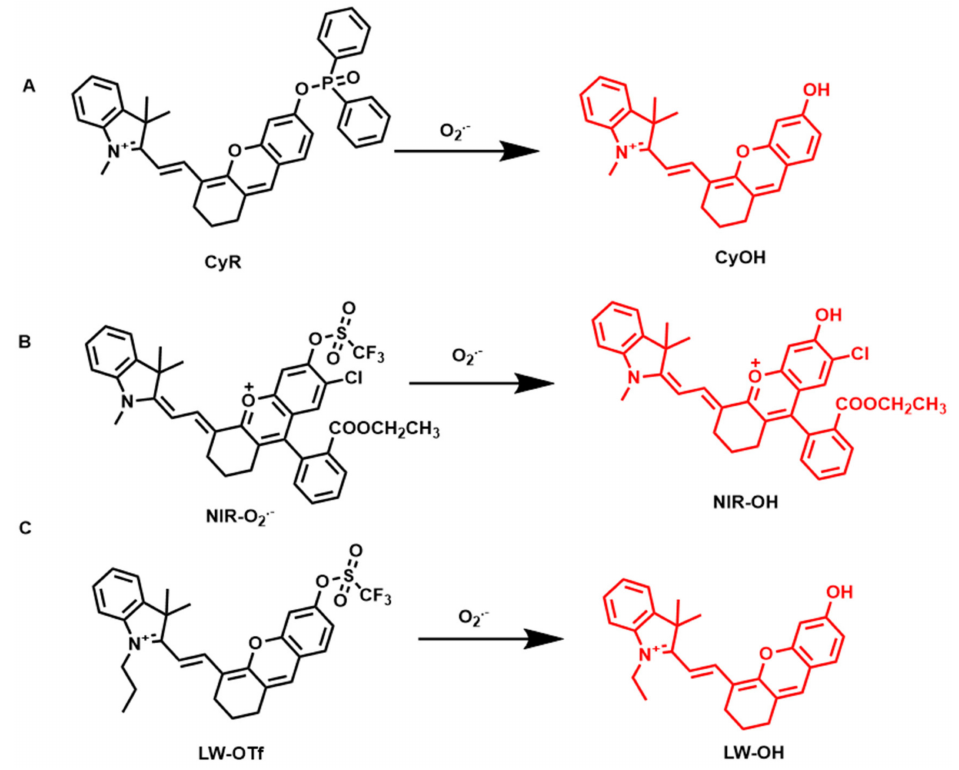
Figure 8. The chemical composition and response mechanisms ( A ) CyR, ( B ) NIR- O 2 ˙ − and ( C ) LW-OTf of the fluorescence probe for O 2 ˙ −